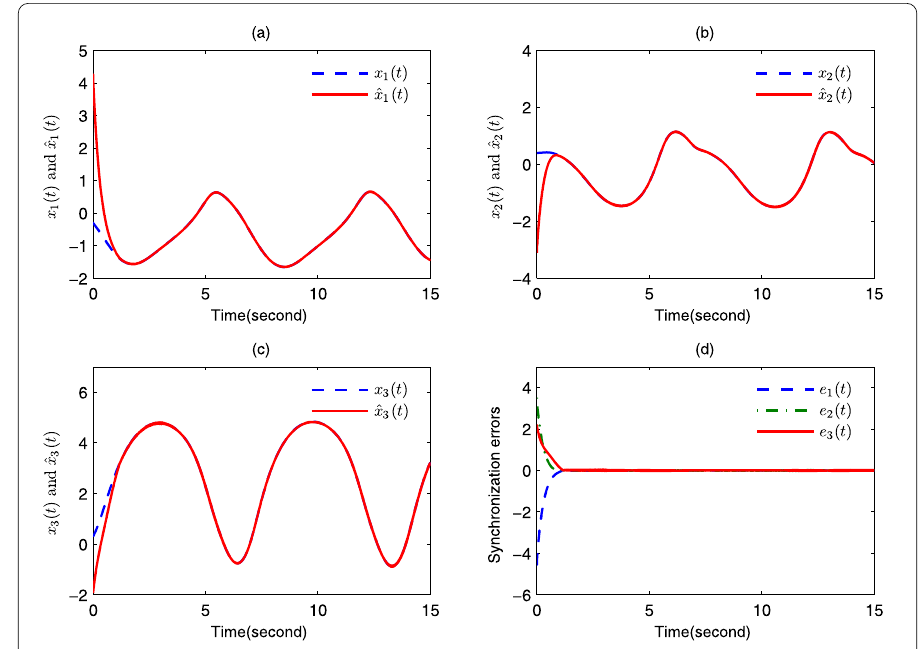
Figure 2 Simulation results when u ( t ) ≡ 0 in ( a ) x 1 ( t ) and ˆ x 1 ( t ); ( b ) x 2 ( t ) and ˆ x 2 ( t ); ( c ) x 3 ( t ) and ˆ x 3 ( t ); ( d ) synchronization errors